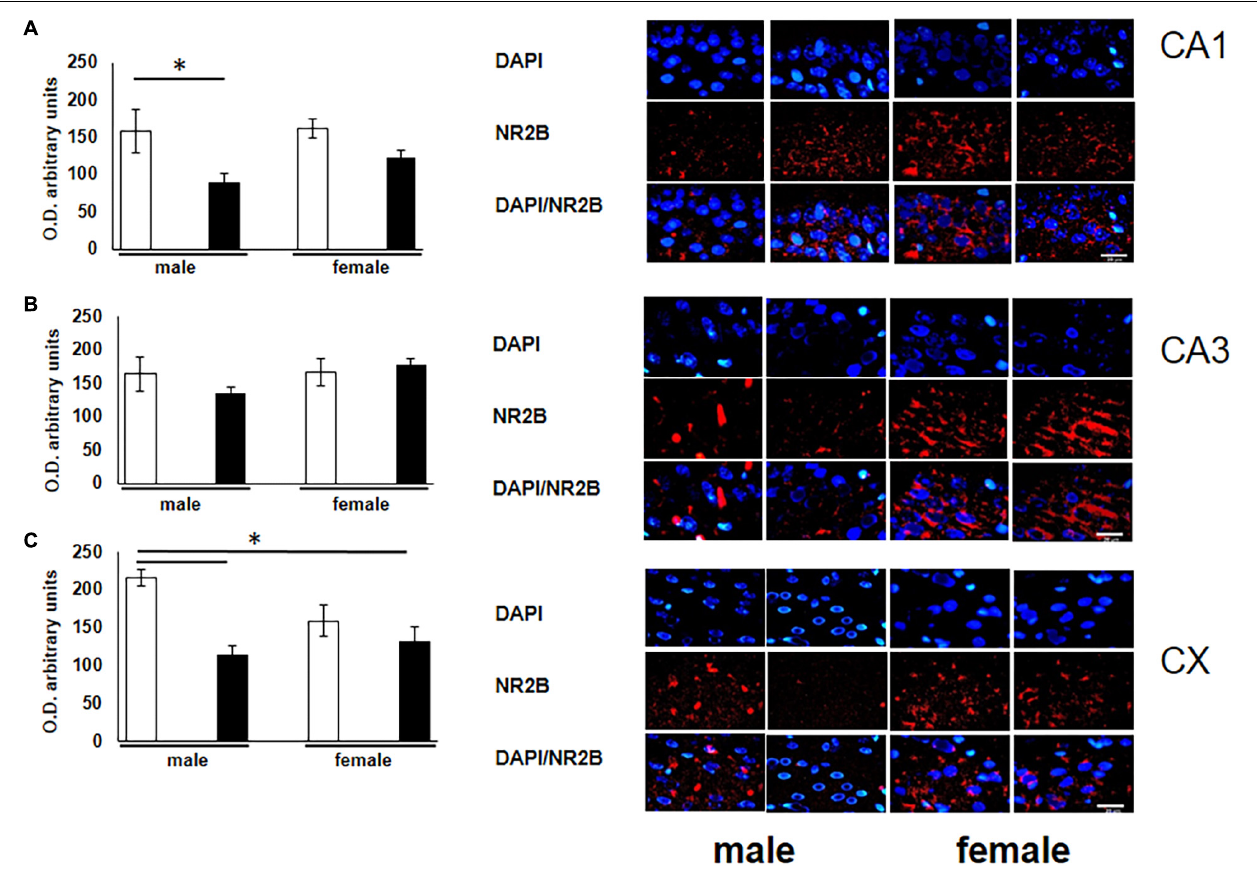
FIGURE 2 | Representative microphotography (objective 60 × and zoom 1.6 × ) showing immunopositivity for the NR2B subunit of the NMDA receptor (red) and DAPI-stained nuclei (blue). The graph indicates optical density arbitrary units for control group (white bars) and ozone group (black bars) in males and females,